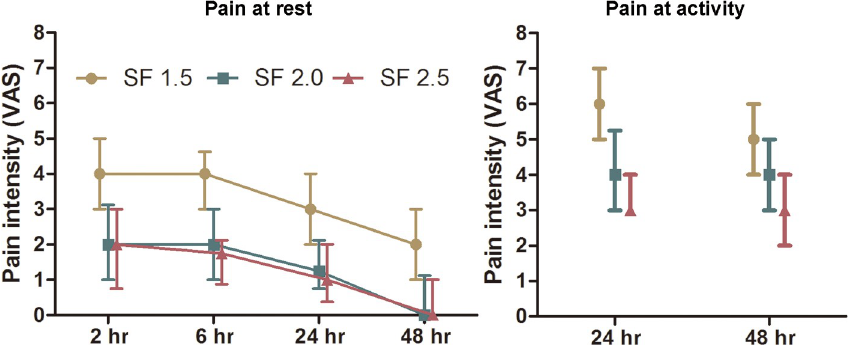
Fig 2. The pain intensity over the first 48 h based on VAS. On the left is the pain intensity at rest over observational time. On the right is the pain intensity when coughing at 24 h and 48 h. The data was presented with median and interquartile